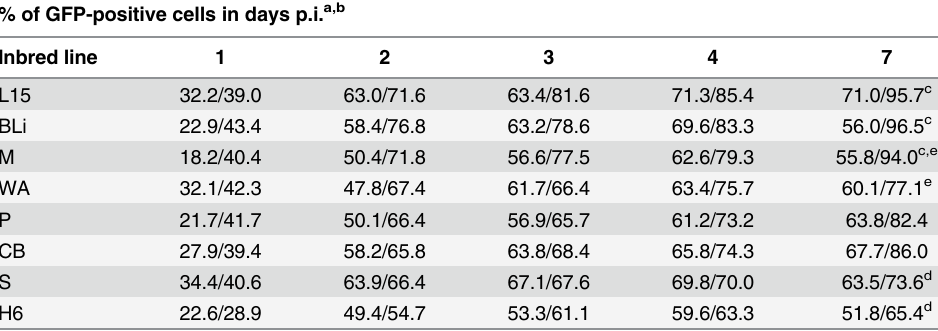
a The natural auto fl uorescence of mock-infected cells was 0.05% of GFP+ cells. b The data show the averages of three parallels, SDE was calculated for each group of three and reached only low values between ± 0.36 and ± 2.38 (not shown). The data of day 7 p.i., MOI = 10 were statistically analyzed using a paired Student´s test. c,d Values denoted c differ signi fi cantly (P < 0.01) from values denoted d.